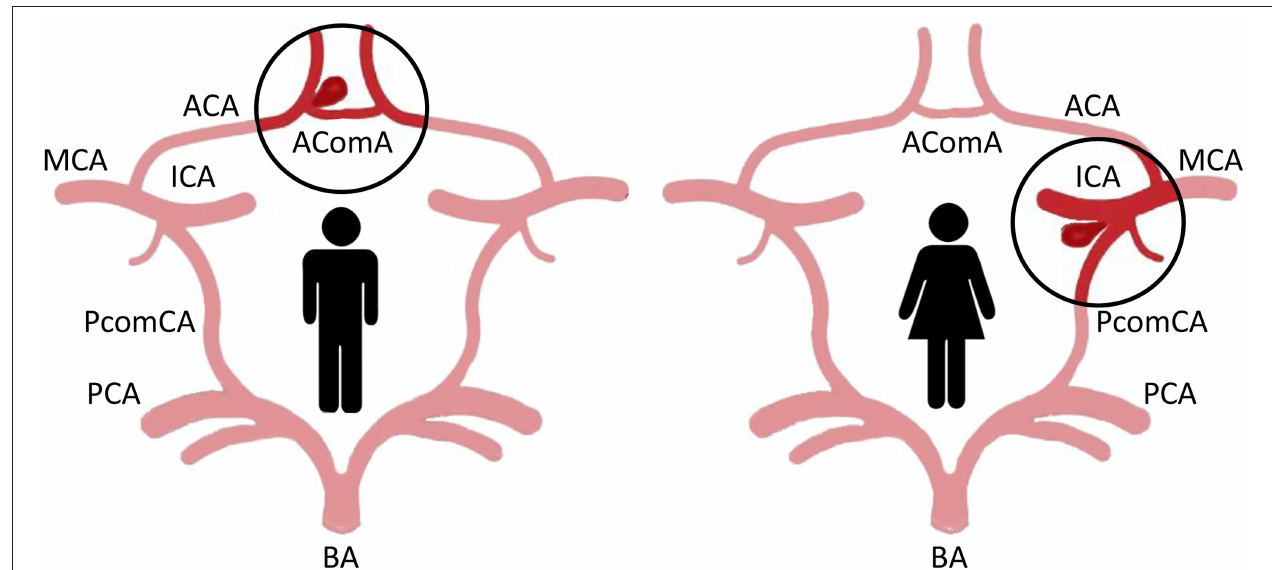
FIGURE 1 | Major localization of IA in the circle of Willis of men and women. In men, IA affects more frequently the anterior cerebral artery (ACA) and anterior communicating artery (AComA; left). In women, IA localizes preferentially on the internal carotid artery (ICA), in particular at the bifurcation with the posterior communicating artery (PComA; right) (MCA, middle cerebral artery; BA, basilar artery; PCA, posterior cerebral